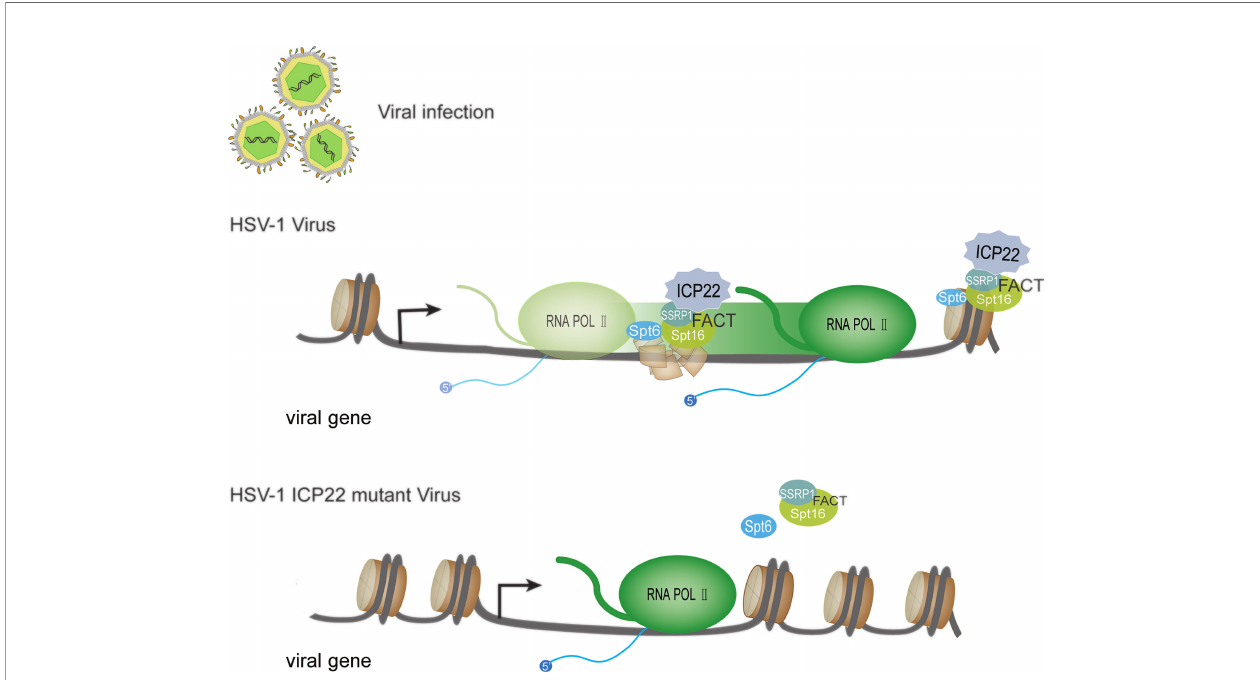
FIGURE 4 | HSV-1 ICP22 affects the ef fi ciency of transcriptional extension through FACT recruitment. In the presence of ICP22, ICP22 can recruit the FACT complex to the viral genome by interacting with the FACT complex, thereby promoting Pol II to cross the nucleosome barrier on the viral genome and achieve effective transcription extension. When the HSV-1 ICP22 mutant infects cells, the number of FACT complex subunits and Spt6 in the genome of the ICP22 mutant is signi fi cantly